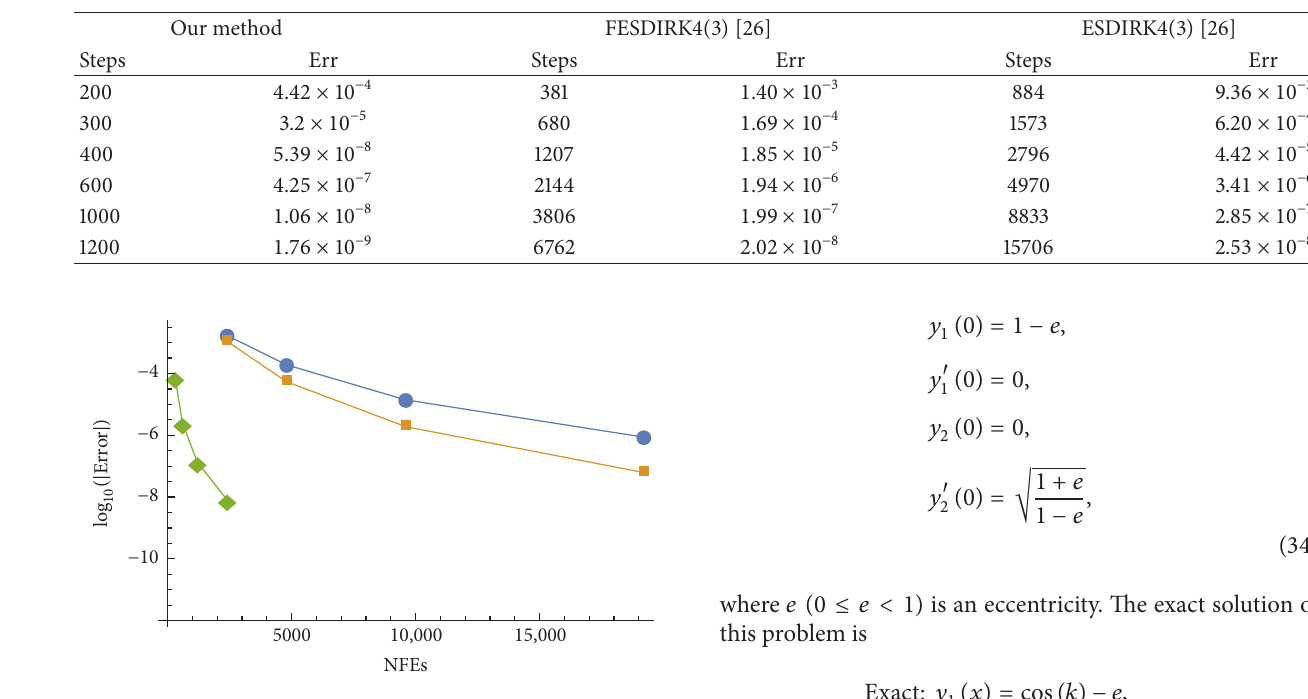
Table 3: Steps and absolute errors, with 𝜔 = 1 , for Example 3 [0, 50𝜋] .